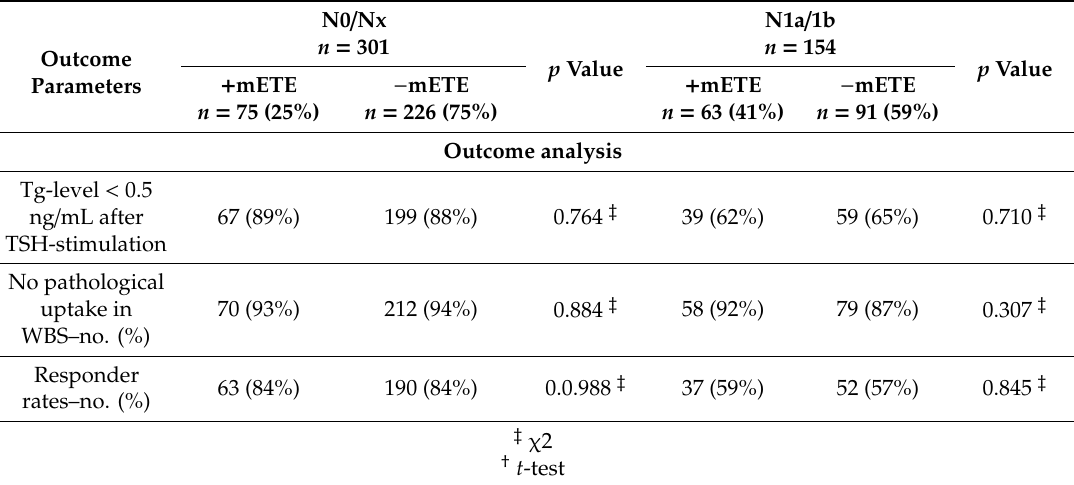
Table 2. Outcome analysis of the subgroups: N0 / Nx and N1a / N1b.